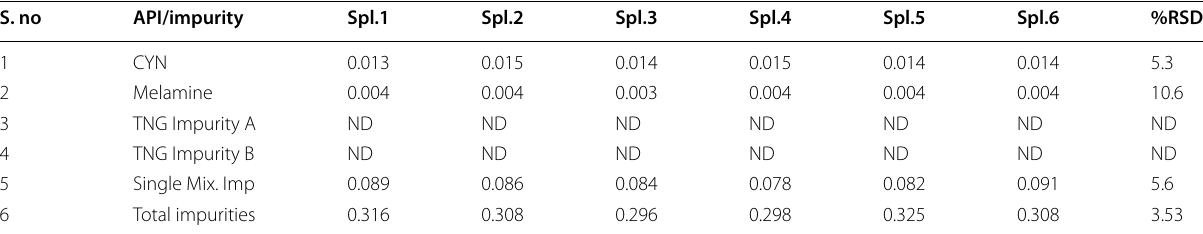
Table 6 Intermediate precision